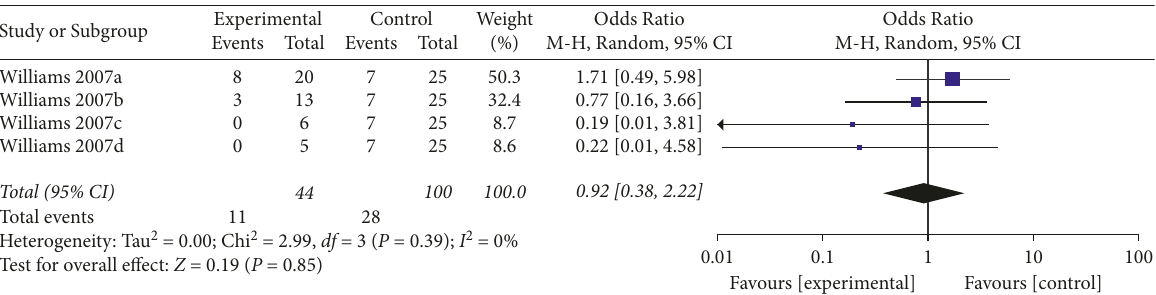
Figure 9: Sensitivity analysis of ADRs associated with antivenom use following snakebite between the prehydrocortisone with or without other drugs groups and the placebo or no premedication groups in four comparisons from one cohort study.